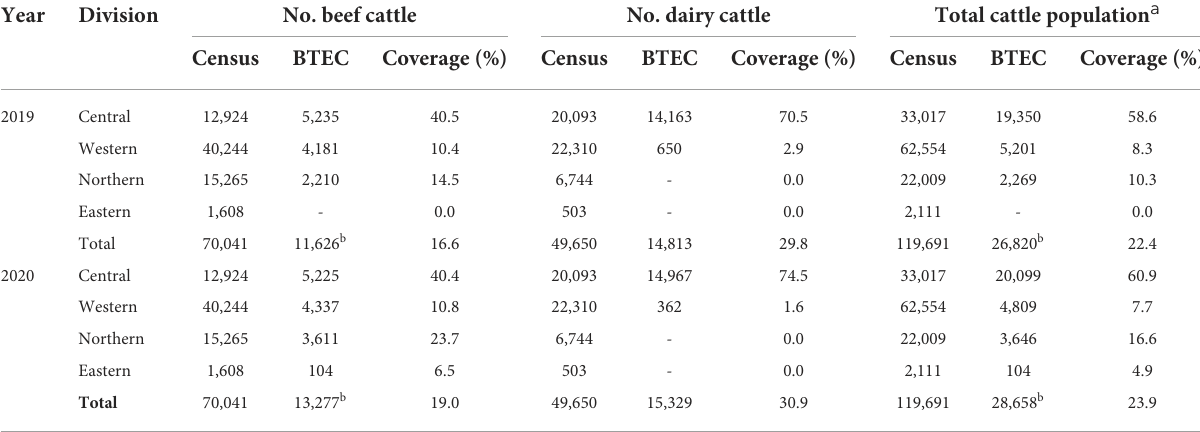
TABLE 3 BTEC coverage of beef cattle, dairy cattle, and the total cattle population in Fiji by division in 2019 and 2020. All data were unique